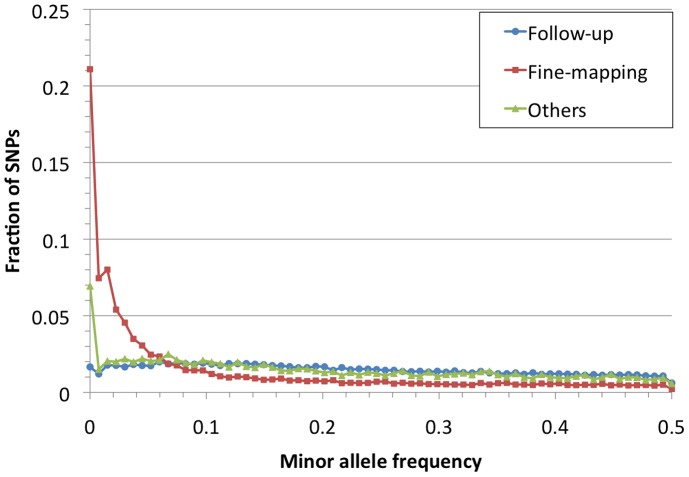
Allele frequency spectrum for Metabochip SNPs by design category.Blue dots, red squares, and green triangles display fractions of replication, fine-mapping, and all other SNPs (see Table 2) in each of the tabulated minor allele-frequency bins. CNP = copy number polymorphism.